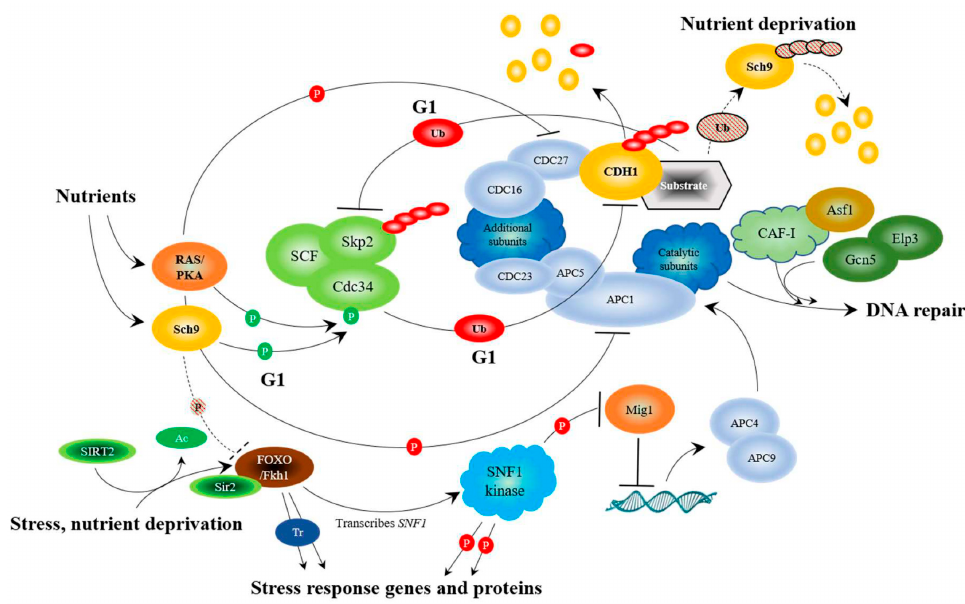
Figure 3. APC activity is decreased under nutrient conditions, and increased when nutrients are limiting. Inhibition of APC activity by glucose is mediated by the Ras/PKA pathway [81,101–103]. Recent work suggests that this is accomplished by driving the activity of the SCF ubiquitin ligase by the phosphorylation and activation of the SCF E2 component Cdc34 by the nutrient response kinases PKA and Sch9 (AKT/S6K) [104]. This could mediate APC inhibition, as it has been shown that the SCF targets the degradation of CDH1 during mitosis [58,105]. Our unpublished data also reveals that Sch9 likely inhibits Fkh1 function, and the subsequent induction of the stress pathways. Upon encountering stress, SIRT2 deacetylates and activates FOXO proteins [106], and in yeast, Sir2 physically associates with Fkh1 to facilitate inhibition of CLB2 transcription in late M/G1 [107]. Fkh1 transcribes stress response genes (depicted by a a blue shaded “Tr”), including SNF1 , which encodes the catalytic component of the SNF1 kinase, the yeast AMPK [79,108]. FOXO and AMPK interact across evolutionary boundaries to deal with stress [108–110]. The SNF1 kinase then enters the nucleus and inhibits the glucose responsive repressor Mig1, which represses the expression of the APC subunits APC4 and APC9 under nutrient conditions [61]. DNA repair is likely mediated, at least in part, by the APC, which controls the deposition and modification of histones during mitosis, which plays a pivotal role in DNA repair [67,69,71–74]. Inhibition of SCF-Cdc34 following APC activation is accomplished in two ways: first, the APC targets the SCF F-box protein Skp2 for degradation in G1 [111,112], and second, our unpublished data shows that the APC targets Sch9 for degradation once nutrients are depleted. Preliminary unpublished data is shown using dashed lines.